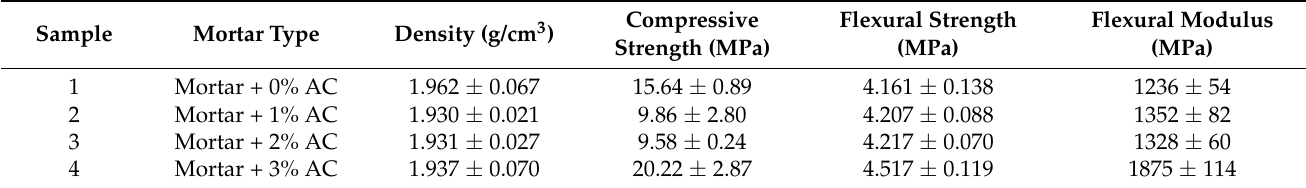
Table 2. The mortar mechanical properties with activated carbon